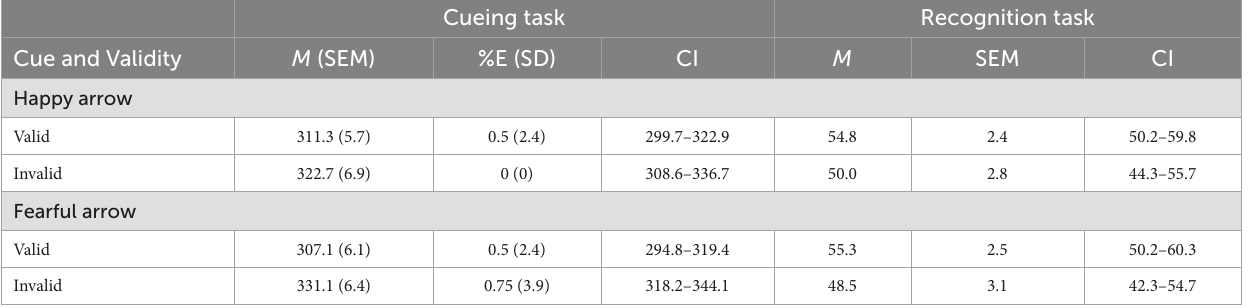
TABLE 3 Mean response times (ms) in the cueing task and mean accuracy (%) in the recognition task as a function of cue and validity in Experiment 2B. Cueing task Recognition